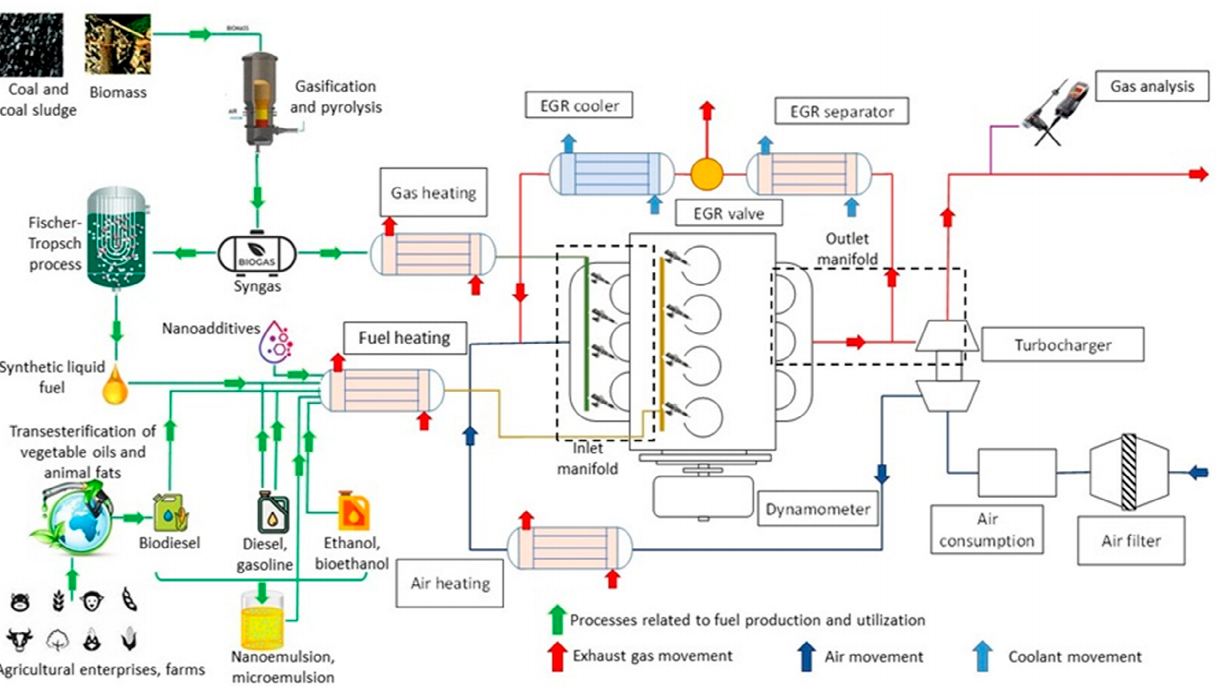
Figure 4. Schematic flow diagram of a dual-fuel engine running on mixtures of syngas and conventional liquid fuels with the addition of biofuels or heterogeneous emulsion liquids.